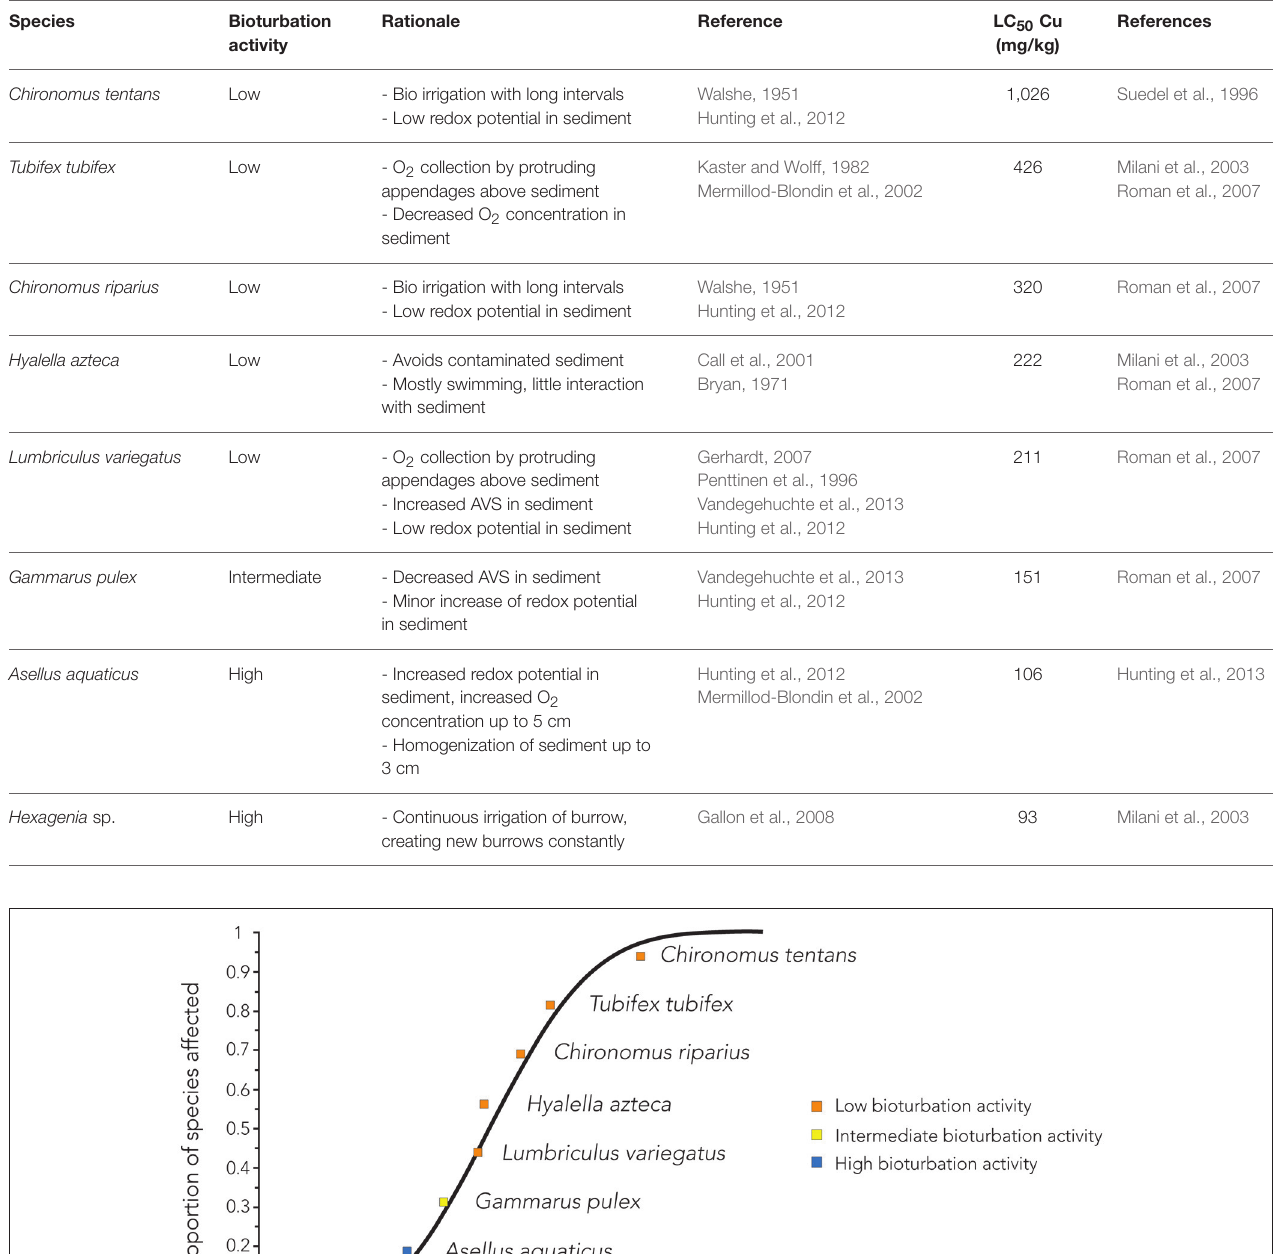
TABLE 1 | Benthic invertebrate bioturbation activity and sediment associated Cu LC 50 values derived from literature. Species